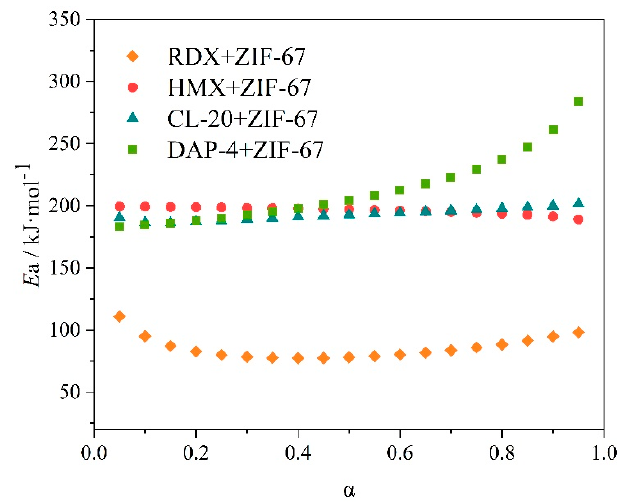
Figure 11. Ea- α relationships of four composites during the thermal decomposition process.